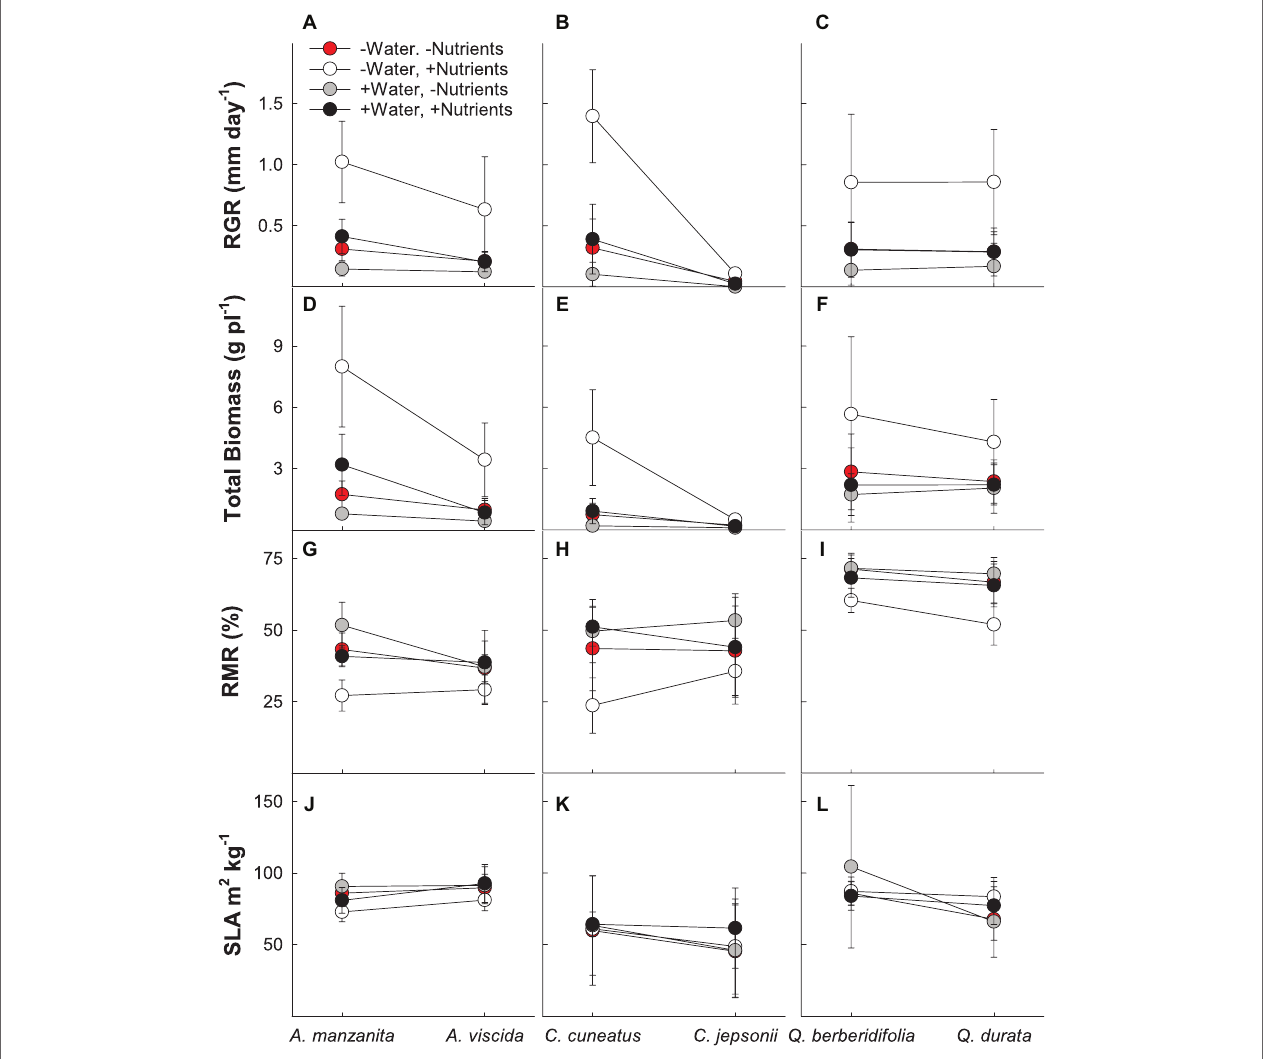
FIGURE 2 | Growth and allocation responses of plants exposed to contrasting water and nutrient treatments, including relative growth rate (RGR; A–C ), total biomass per plant (D–F) , root mass ratio (RMR; G–I ), and specific leaf area (SLA; J–L ). First plant in each congener pair originates from non-serpentine soil; second plant in each congener pair originates from serpentine soil. Data are means ± S.D. ( n =